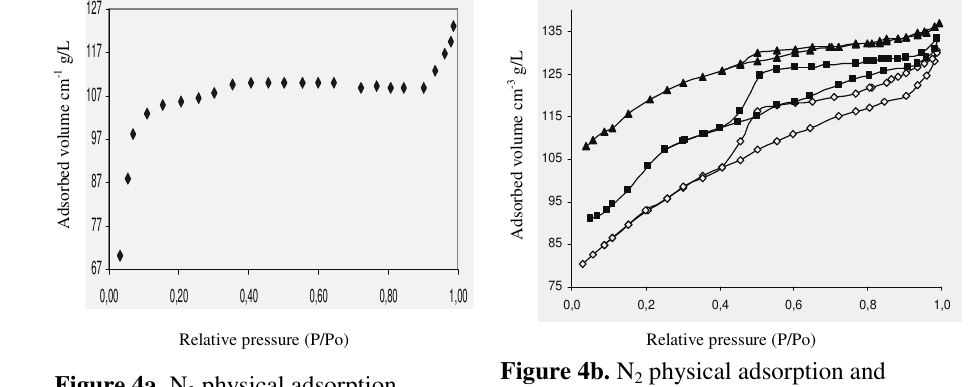
Figure 4a. N physical adsorption 2 isotherms ZSM-5.